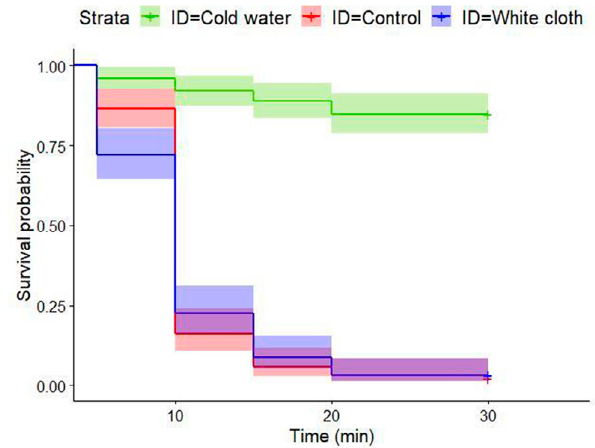
Fig. 4. – Kaplan-Meier survival on board curves (with 95% confidence intervals) for N. norvegicus over time exposed to treatment 2-cold water (green), the control (red) and treatment 1-white cloth (purple); data were pooled across replicates. Values near to 1 represent a high survival rate while values near to 0 represent a low survival